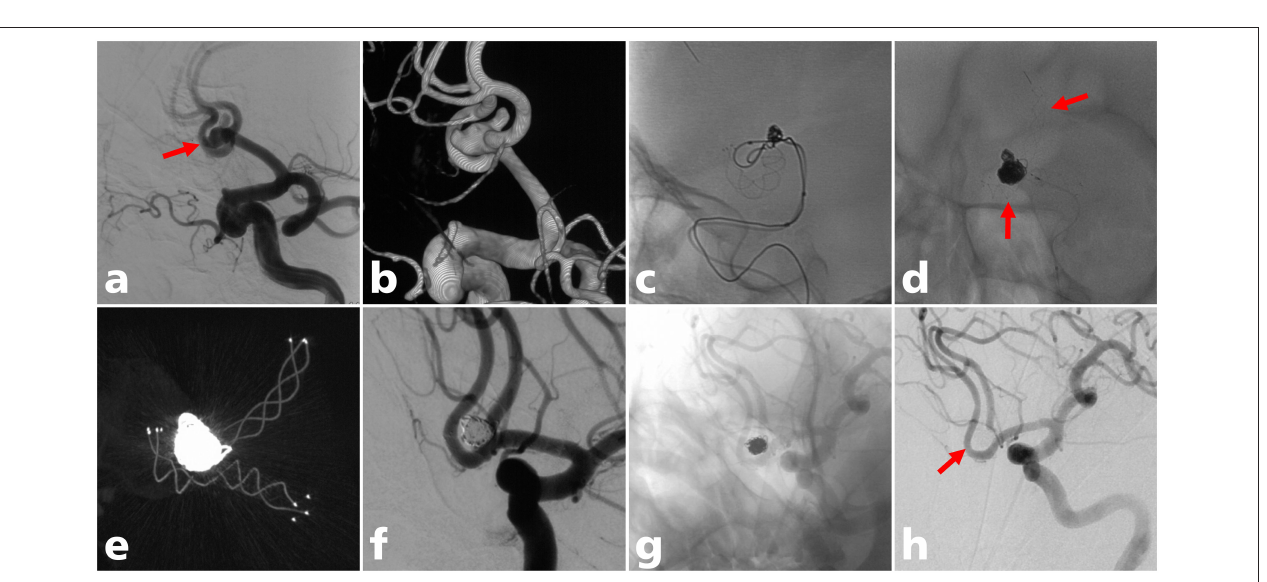
FIGURE 2 | A 60-year-old man with an ACoA aneurysm treated with LVIS stent-assisted coiling with a T configuration. (a) Angiogram showed a wide-neck ACoA aneurysm (solid arrow); (b) three-dimensional reconstruction of the aneurysm; (c) the LVIS stent (3.5mm × 20mm) was successfully deployed crossing the ACoA to the contralateral A2 segment; (d) the LVIS Jr stent (3.5mm × 18mm) was successfully deployed from the ipsilateral A2 to the A1 segment in a T configuration (solid arrow); (e) postoperative CT reconstruction showed that the two stents were complete opened (f) partial occlusion (modified Raymond-Roy class IIIa) was achieved under final view; (g,h) complete occlusion (modified Raymond-Roy class I) of the aneurysm at last angiographic follow-up (solid